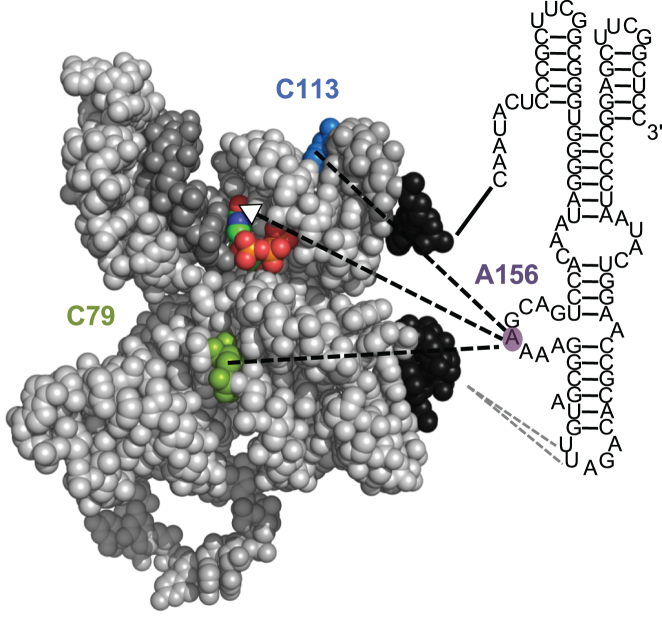
Model for the interaction between A156 (purple background) and the ligase core (gray). The NTP in the active site (atom colors), position C79 (green), and position C113 (blue) are highlighted. The results of this study suggest a direct interaction between A156 and the NTP, and indirect interactions (dashed lines) between A156 and C79, and between A156 and C113. The white arrowhead of the dashed line between A156 and the NTP points towards position 6 of the NTP nucleobase, which may serve as hydrogen donor to position 156 (see text). Note that the X-ray structure corresponds to GTP in the active site therefore the red sphere (oxygen) corresponds to the 6-thio position of 6sGTP.